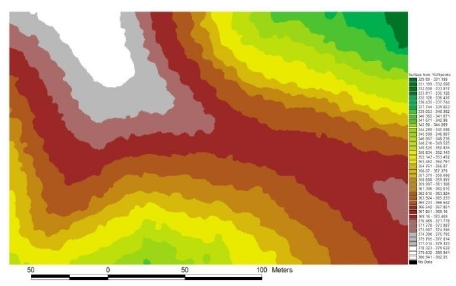
Figure 9. DEM created from reduced LiDAR data down to point cloud density of 0.037pts/m 2